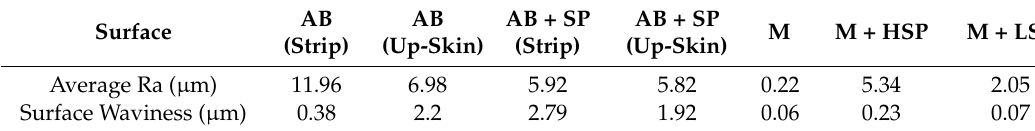
Table 3. The effect of shot peening on both surface roughness and waviness.